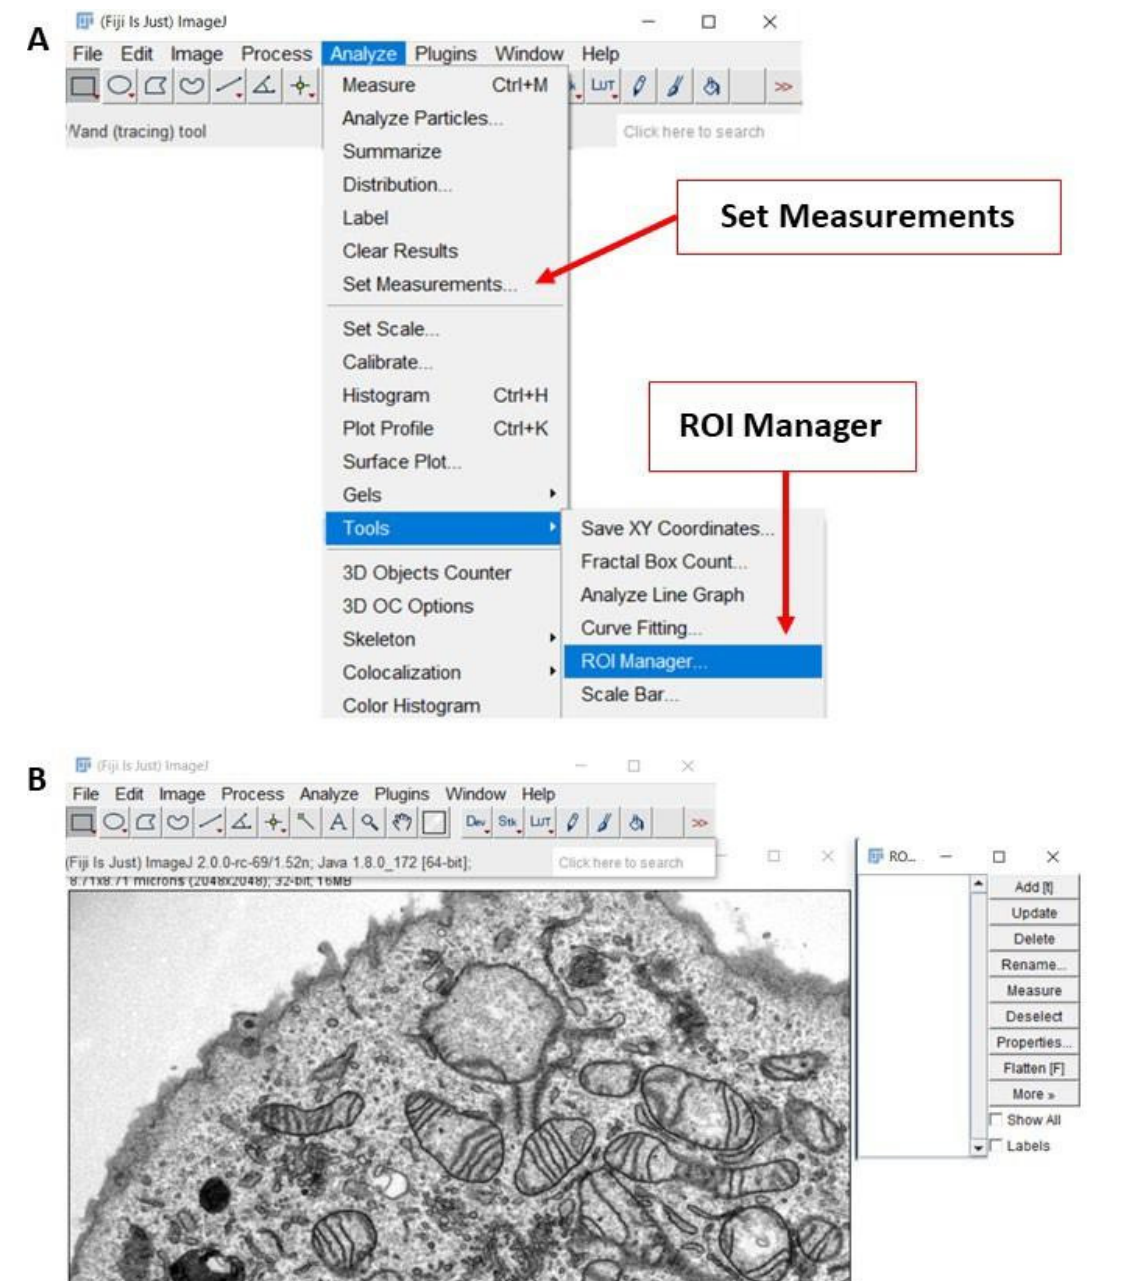
Figure 1. Preparing ImageJ software for image analysis. ( A ) On the ImageJ toolbar, the “Analyze” menu contains many of the settings and tools needed for this analysis method. ( B ) Representative screenshot of a transmission electron microscopy (TEM) image that is ready to be analyzed. The ROI menu is shown to the right TEM image.